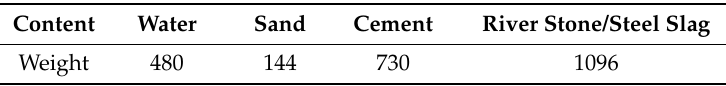
Table 1. Mixture proportion of the concrete (by weight kg/m 3 ).